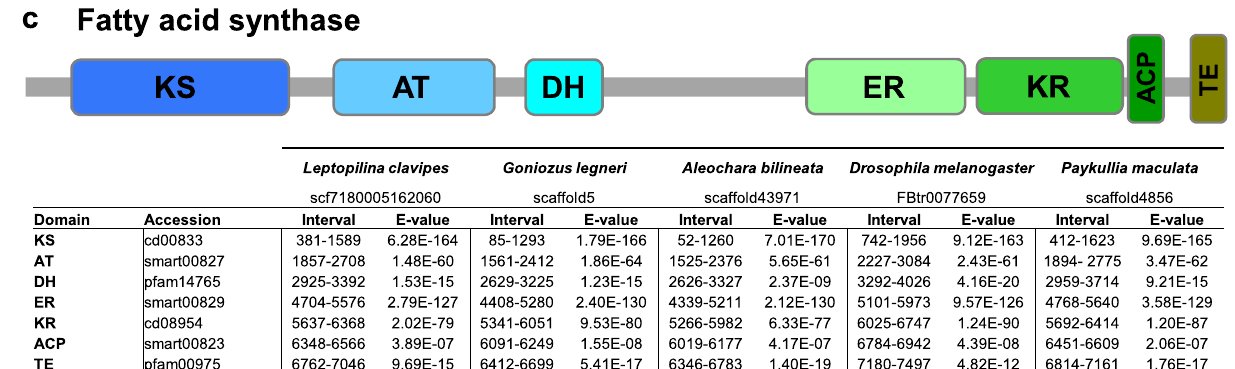
Figure 2. Conservation of two genes crucial for fatty acid synthesis in four parasitoid insects that supposedly had lost lipogenic activity. Long evolutionary divergence times (up to 350 MA) separate the insect Drosophila melanogaster (that synthesizes lipids constitutively) and 4 parasitoid insects that were assumed to have lost the ability to synthesize lipids ( a ). Acetyl coenzyme A carboxylase (ACC) and fatty acid synthase (FAS) are two essential genes for the production of fatty acids: the presence of all domains of ACC ( b ) and FAS ( c ) genes from D. melanogaster in the four parasitoid genomes reveals that the functional coding sequence of the two genes is conserved in these insects. A table containing the detailed length and position of the different functional domains forming the two genes, as well as conservation level of the nucleotide sequence of the domains (e-values; the lower the e-value, the higher the significance of the match) are shown for each species. Abbreviations: BC = Biotin carboxylase; BCCP = Biotin carboxyl carrier protein; ACCC = Acetyl- coA carboxylase central region; CT = Carboxyl transferase domain; KS = Ketoacyl synthase; AT = Acyl transferase; DH = Dehydratase; ER = Enoyl reductase; KR = Ketoacyl reductase; ACP = Acyl carrier protein; TE = Thioesterase. Accession numbers refer to the conserved domain identifier on NCBI’s Conserved Domain Database. Parasitoid transcript identifiers are provided underneath each species